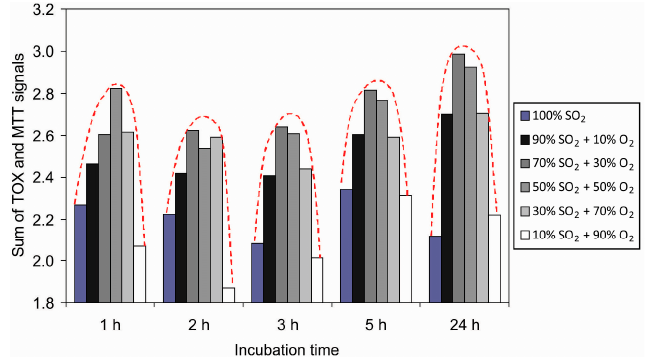
Figure 11. The sum of deviations from untreated samples observed for the MTT and TOX tests.